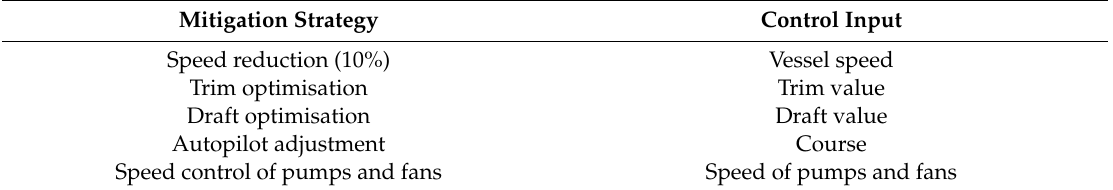
Table 2. Control inputs for di ff erent mitigation